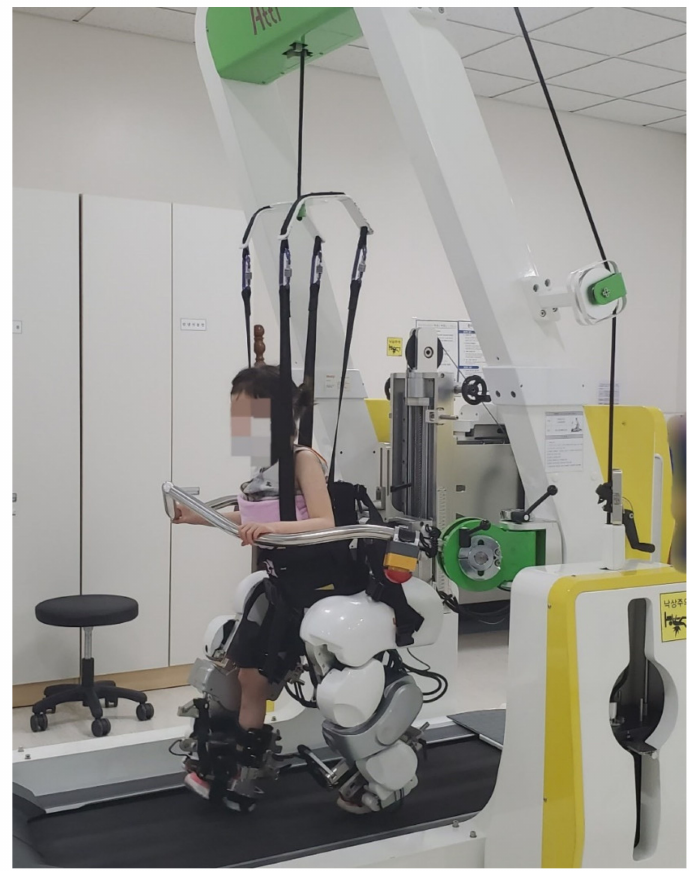
Figure 2. Robotic-assisted gait training using